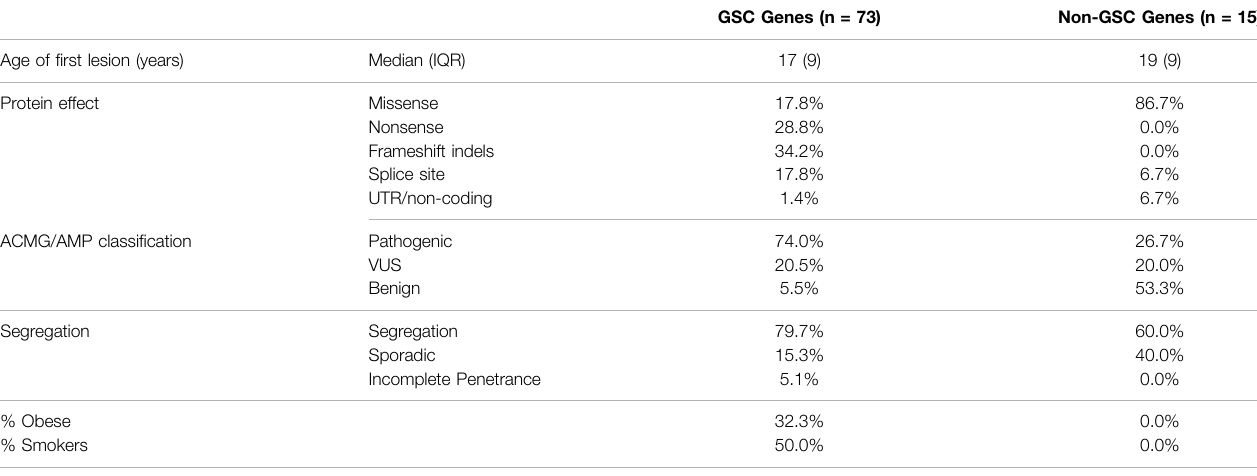
TABLE2| Acomparisonofthesalientclinicalandgenetic fi ndingsbetweenHScasesbearingvariantsin γ -secretasecomplexgenesandHScaseswithvariantsatotherloci. All non-GSC genes ( PSTPIP, MEFV, NOD2, IL1RN and NLRP3 ) that have been associated with HS subtypes are considered as an aggregate